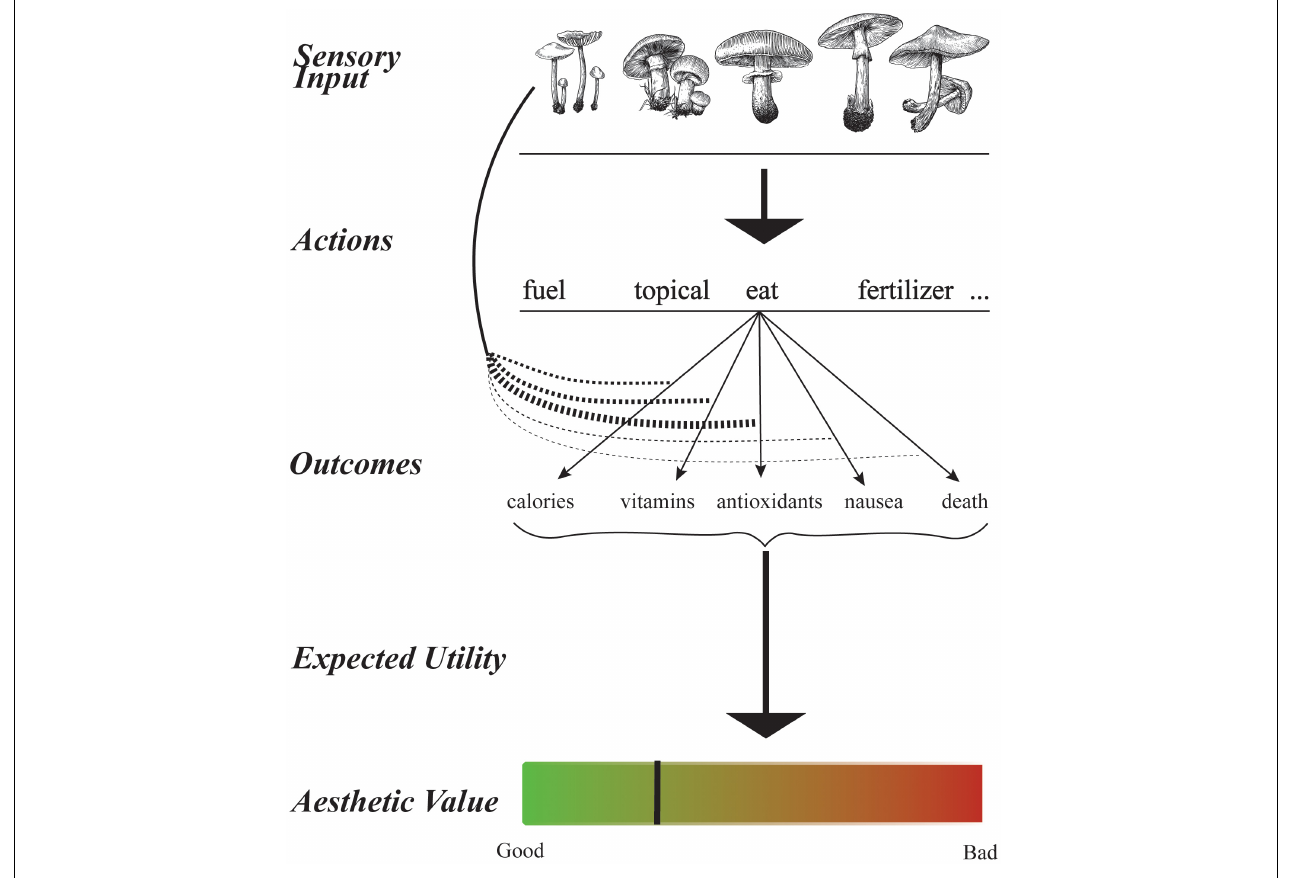
FIGURE 1 | Illustration of proposed relationship between the expected utility hypothesis and aesthetic values. Suppose that a person is seeing a mushroom. The person has many actions from which to choose. The possible actions include, among others, using the mushroom as fuel, topical medicine, food, or fertilizer. When trying to decide what action to take, the person must see to what outcomes an action may lead. For example, the action of eating a mushroom can provide positive or negative utilities such as calories, vitamins, antioxidants, nausea, or death. The Expected Utility Hypothesis proposes to decide what action to take by finding the mean utility of each action and using the optimum. The mean utility considers the probability that an action will lead to each outcome given the sensory input. The probabilities for eating the leftmost mushroom are indicated by the thicknesses of the curved arrows. We propose to equate aesthetic value is a special case of expected utility. For aesthetic values, the only action is evaluation. If the statistics of the sensory input are like those of objects with high expected utility, the aesthetic value of the input is high (Aleem et al., 2019,